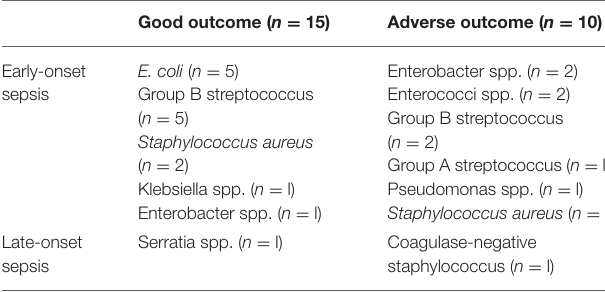
TABLE 2 | Bacterial organisms detected via positive blood culture.